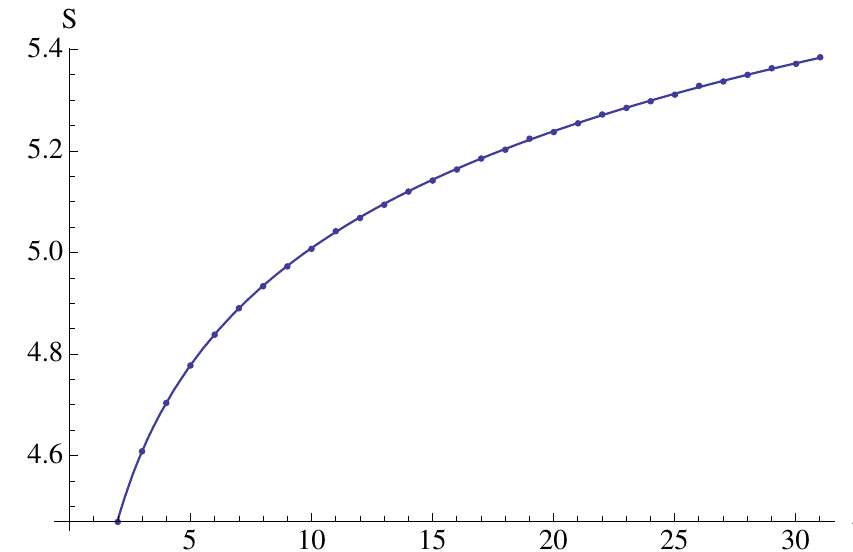
Figure 1 . S vs. ‘=a for a chain of harmonic oscillators with periodic boundary